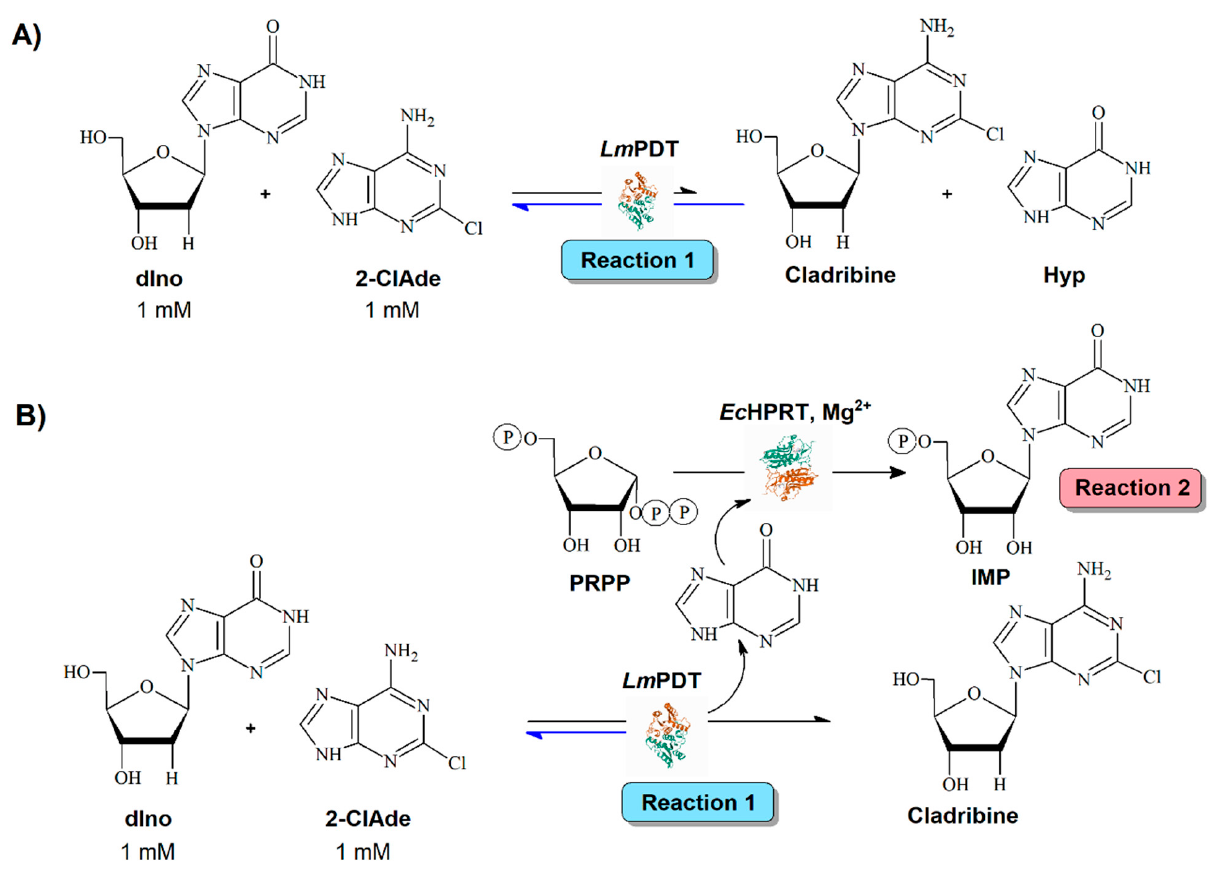
Figure 1. Enzymatic synthesis of Cladribine catalyzed by: ( A ) Lm PDT. ( B ) Lm PDT/ Ec HPRT. dIno: 2 (cid:48) -deoxyinosine; 2-ClAde: 2-chloroadenine; Hyp: hypoxanthine; PRPP: 5-phospho- α -D-ribosyl-1- pyrophosphate; Lm PDT: Leishmania mexicana purine 2 (cid:48) -deoxyribosyltransferase; Ec HPRT; Escherichia coli hypoxanthine phosphoribosyltransferase.